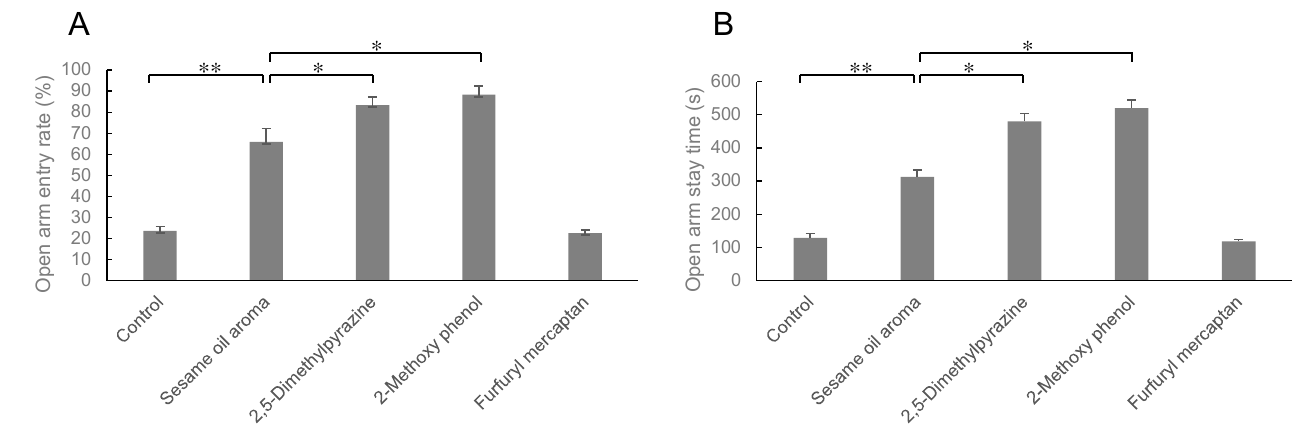
Figure 3. Elevated plus-maze test. ( A ): open arm entry rate (%), ( B ): open arm stay time (s). Results represent mean ± SEM (n = 6). * p < 0.05, ** p < 0.01 (Two-way ANOVA followed by Tukey’s test or Student’s t -test).